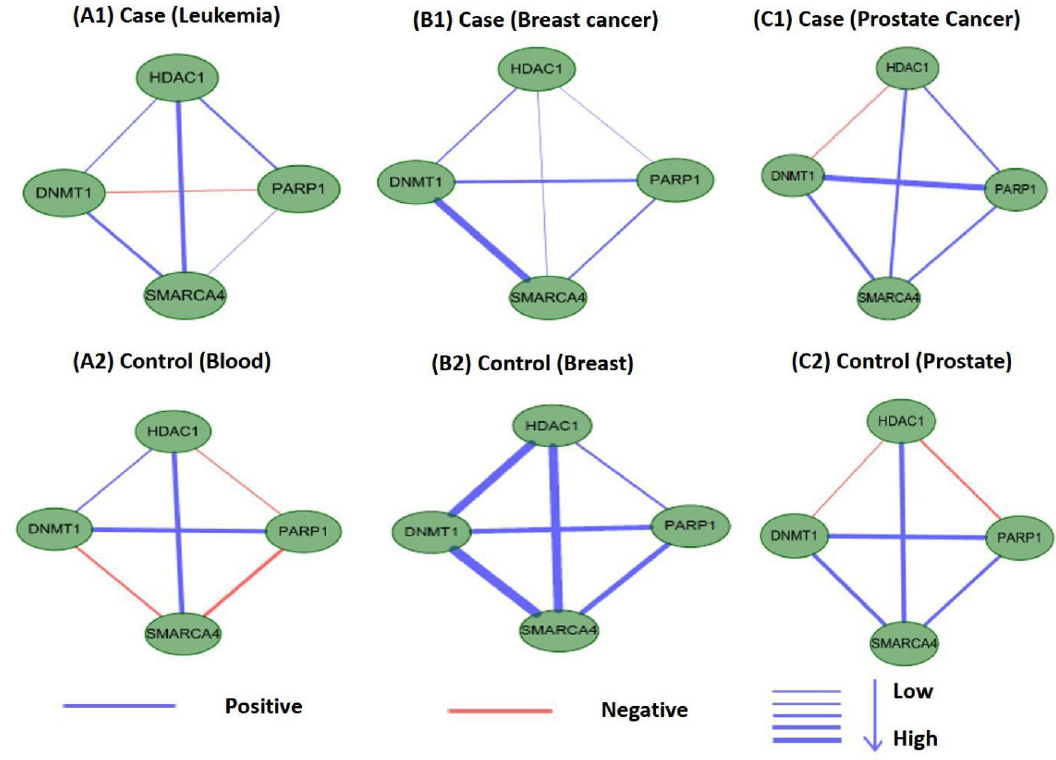
Figure 12. Differences in the co-expression network connections of M17 in normal and tumor-based states under three different conditions (leukemia, breast cancer, and prostate cancer).